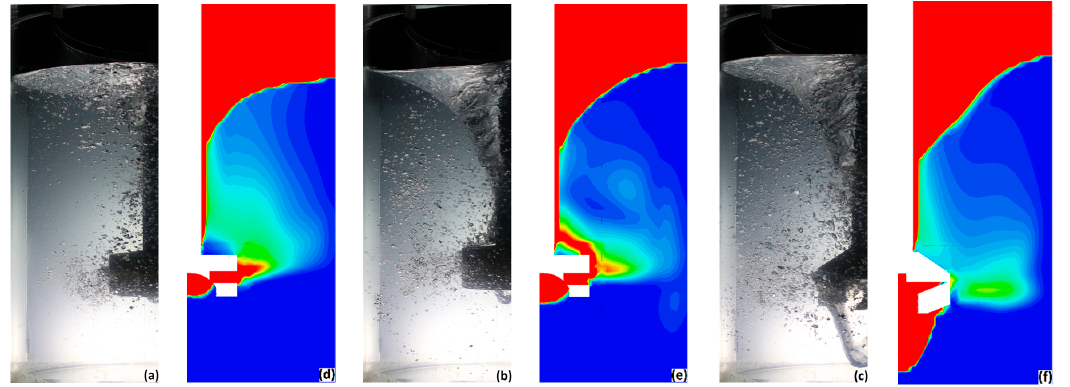
Figure 5. Comparison between measured and computed gas holdup fields. Gas holdup in the r-z plane of the ladle for the three impellers tested at 400 rpm and 10 L/min. Experimental: ( a ) Impeller A; ( b ) impeller B; ( c ) impeller C. Computed: ( d ) Impeller A; ( e ) impeller B; ( f ) impeller C.